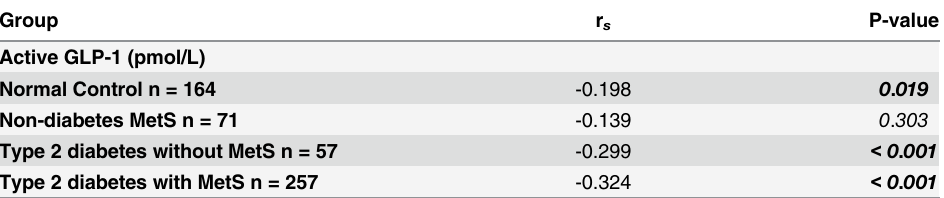
Table 3. Correlation between of fasting serum levels of sCD26/DPP-IV and active GLP-1 among nor- mal, non-diabetic metabolic syndrome, type 2 diabetes mellitus subjects with and without metabolic